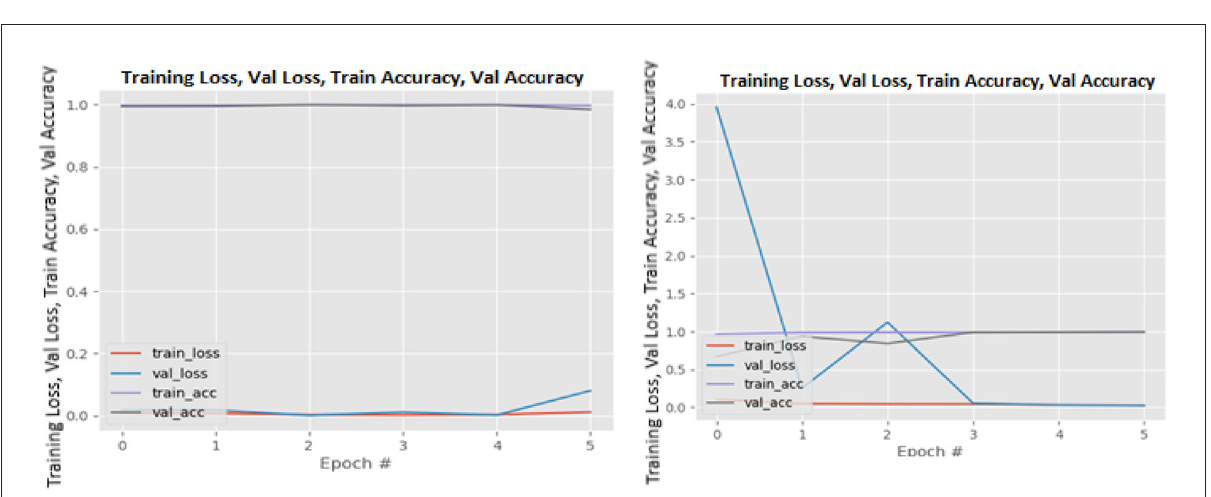
FIGURE12 InceptionV3 without data augmentation (left image) and with data augmentation (right